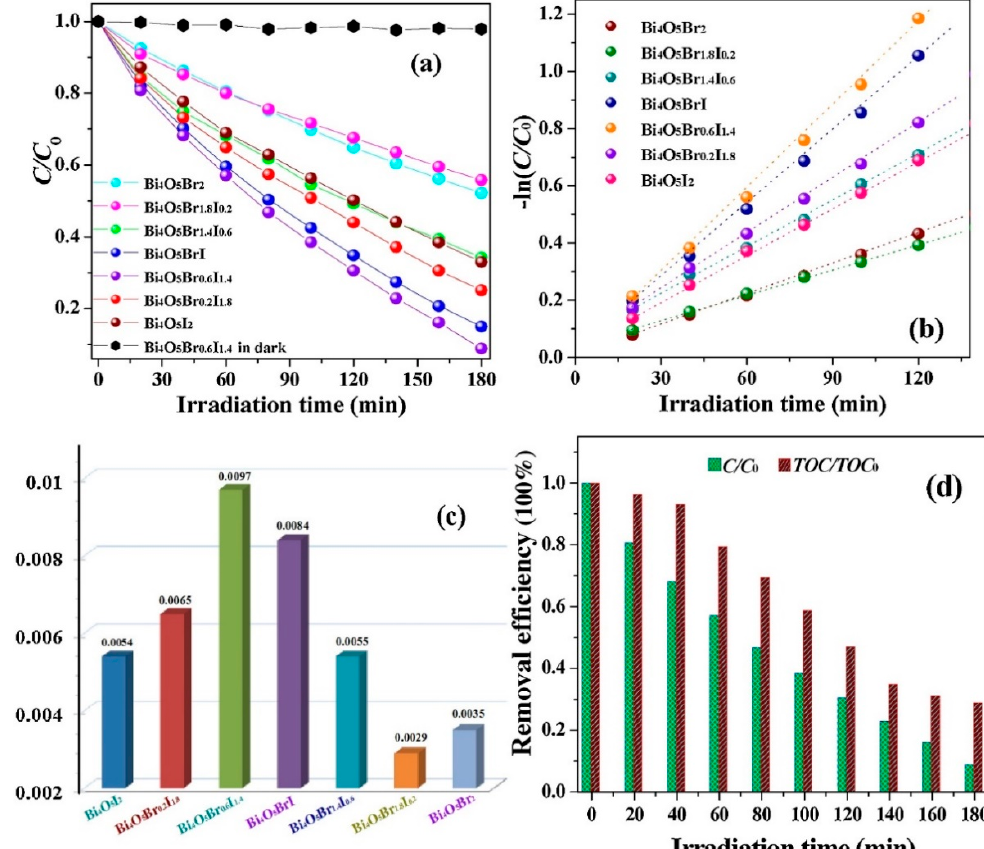
Figure 9. ( a ) Normalized zeroth-order degradation plot for 30 mg/L resorcinol treated with Bi 4 O 5 I 2 , Bi 4 O 5 Br 2 , and Bi 4 O 5 Br x I 2 − x under visible light. ( b ) 1st order degradation plot for the degradation of resorcinol using additional catalysts. ( c ) Degradation constants calculated for resorcinol given treatment with various catalysts. ( d ) Plot of TOC vs. irradiation time for 30 mg/L solutions of resorcinol with Bi 4 O 5 Br 0.6 I 1.4 [116]. Copyright Elsevier 2018.